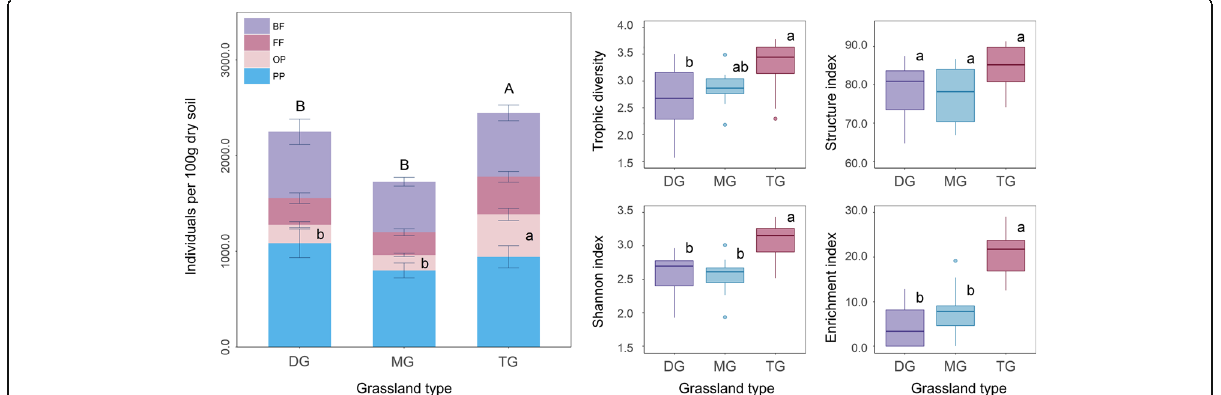
Fig. 3 Changes in soil nematode communities across the grassland degradation gradient. DG, degraded grassland; MG, meadow steppe; TG, grassland from the forest-steppe ecotone. Bars with different letters indicate significant difference at P < 0.05. Error bars represent ±